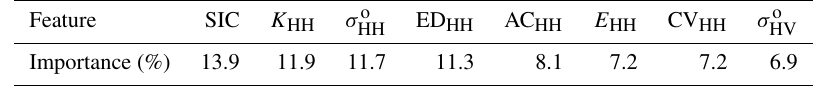
Table 4. The importance of different features when the training data covered the whole test period.